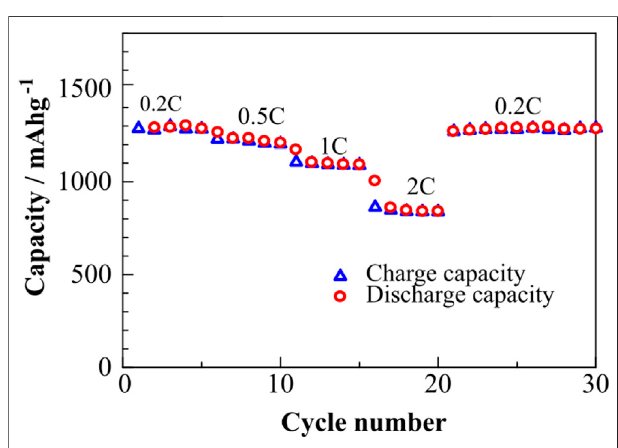
FIGURE 4 | Rate capability of half-cell containing S/PAN/KB composite assembled with Li-metal (0.2 C (cid:2) 300 mA g − 1 and 0.5 C (cid:2) 800 mA g − 1